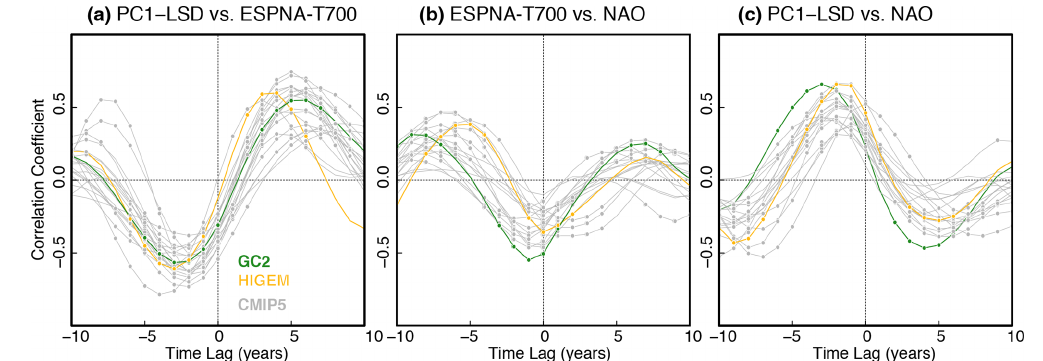
Figure 6. (a) Lead–lag correlations across the picontrol ensemble between the PC1-LSD index and the vertically averaged top 700m tem- peratures in the eastern subpolar gyre (ESPNA-T700; grey box in Fig. 1a). Correlations are based on 10-year running trends. Significance is assessed as in Fig. 2d and is indicated with a circle. For positive lags, PC1-LSD leads. (b–c) The same as in (a) but between the North Atlantic Oscillation (NAO; defined as the standardized difference in sea level pressure between the closest grid points to Azores and Reykjavik) and the ESPNA-T700 and between the NAO and the PC1-LSD, respectively. In these two cases, for negative lags the NAO